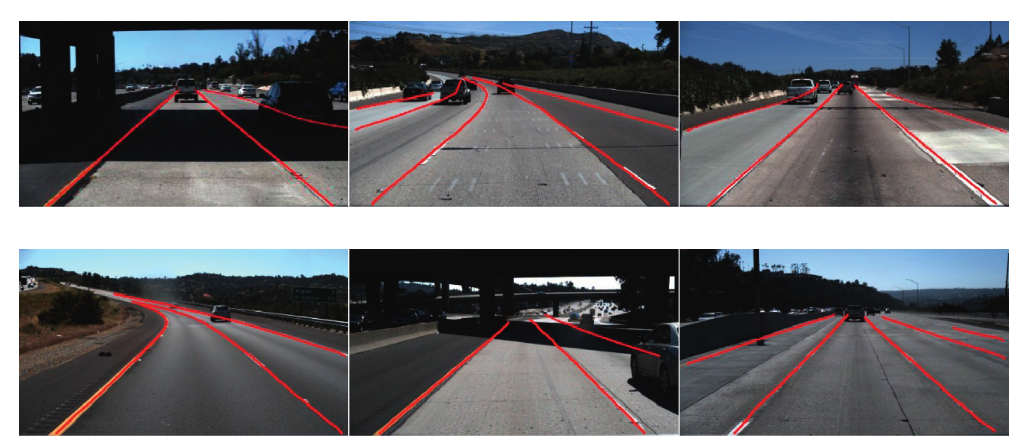
Figure 9: Testing results on